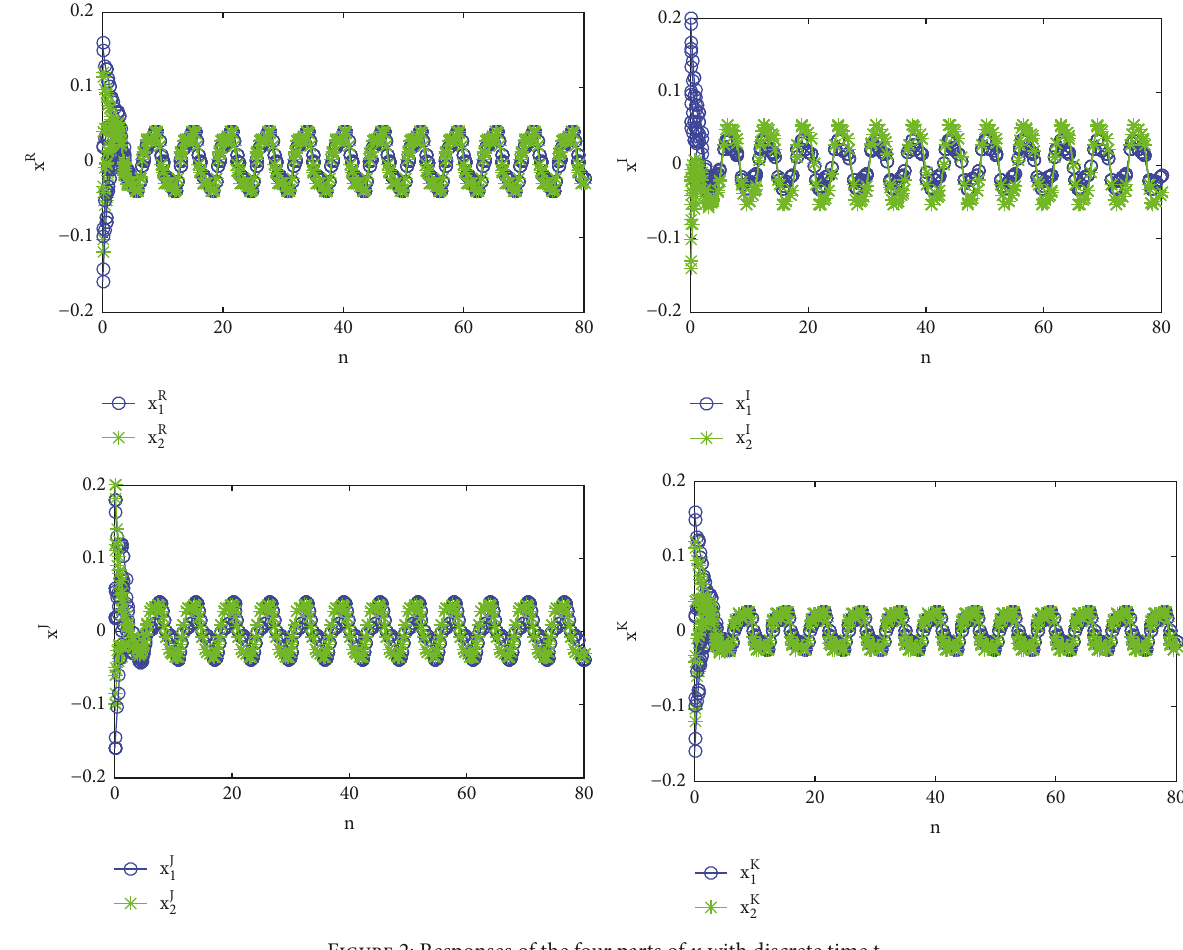
Figure 2: Responses of the four parts of 𝑥 with discrete time